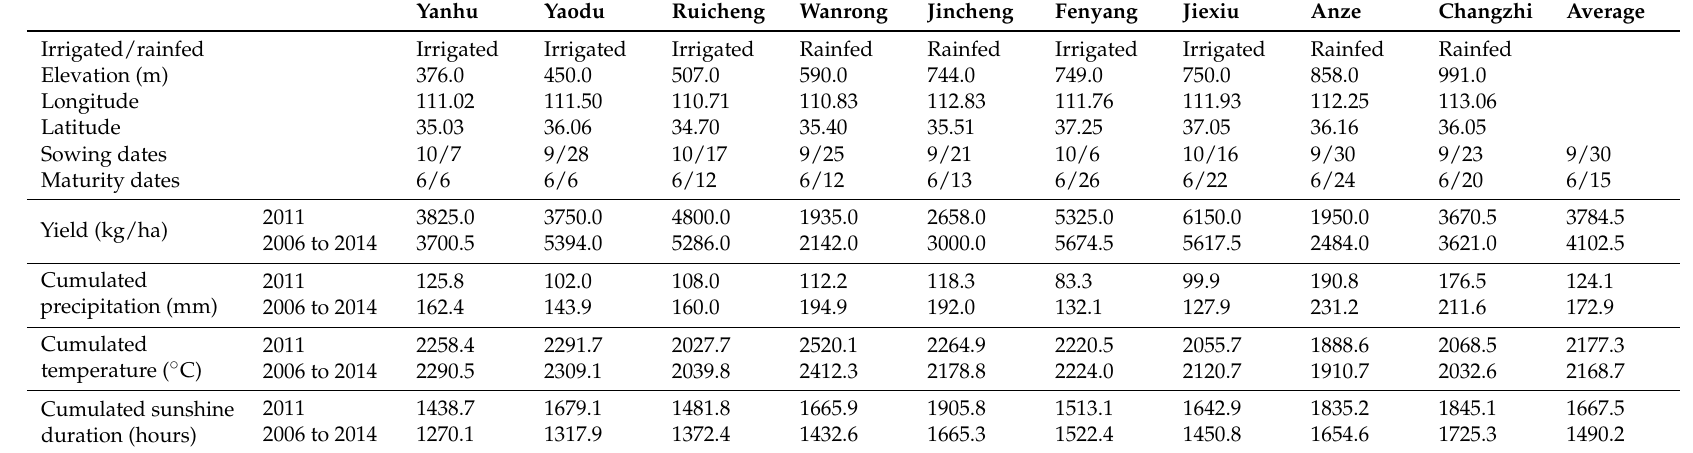
Table 1. Observed environmental conditions and wheat yield at agrometeorological stations in south central Shanxi